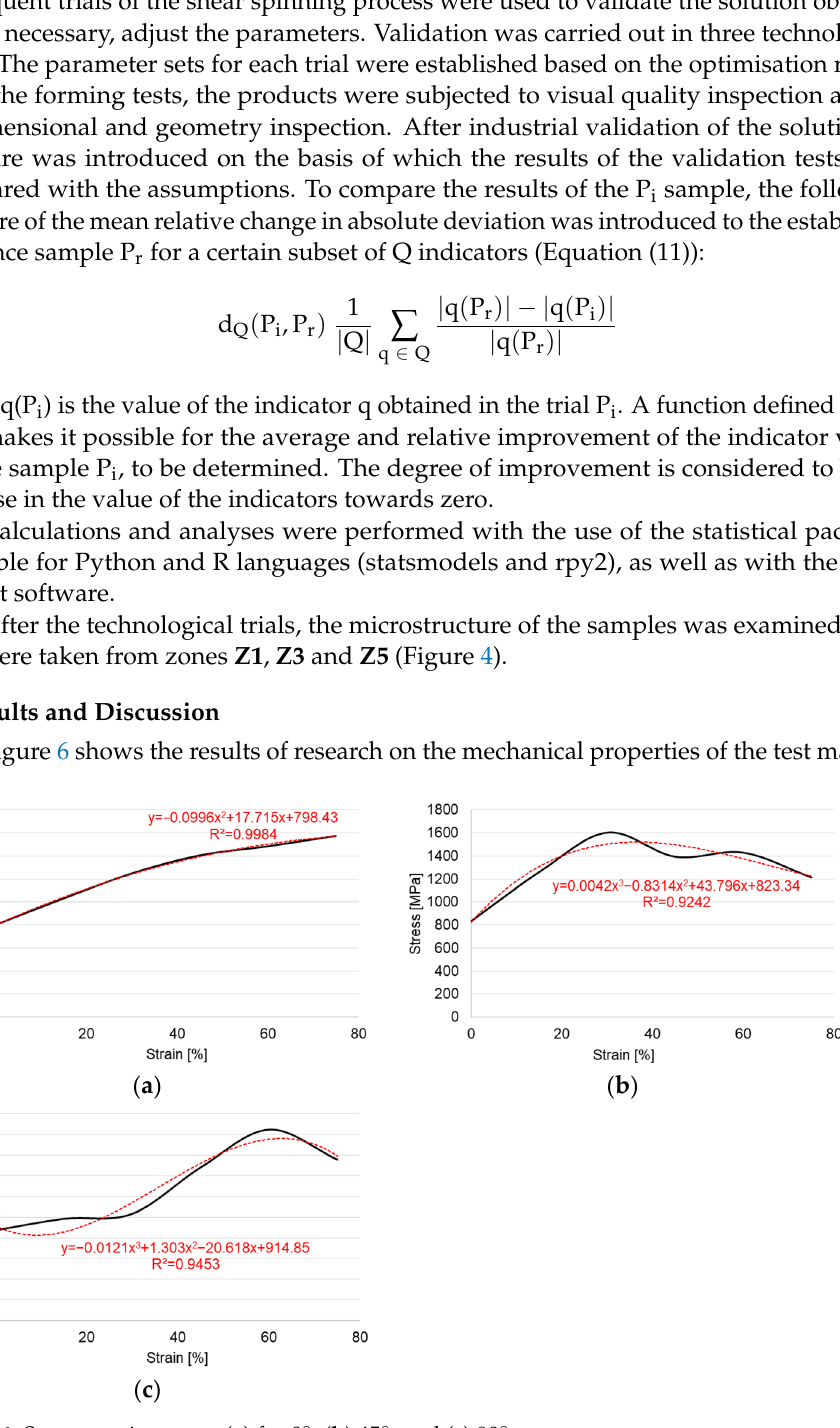
Figure 6. Stress–strain curves ( a ) for 0°, ( b ) 45°, and ( c ) 90°.